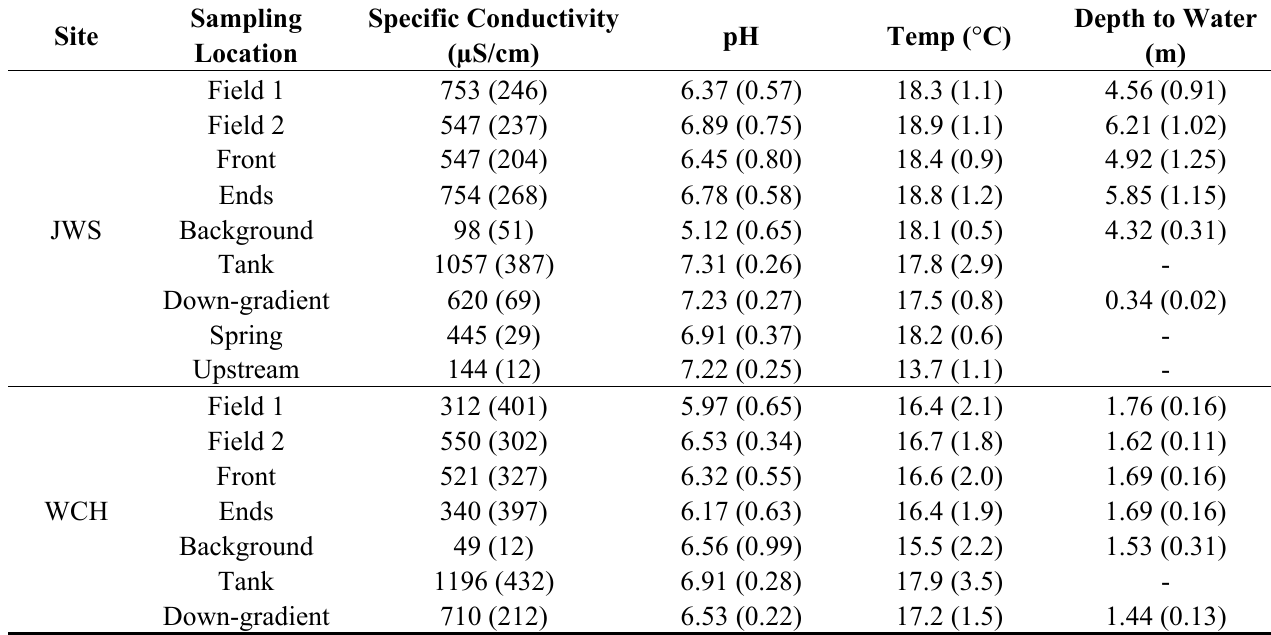
Table 2. Mean and standard deviation (in brackets) physical and chemical properties of water at various sampling locations at James W. Smith and West Craven High. Data indicate higher mean specific conductivity values for groundwater influenced by